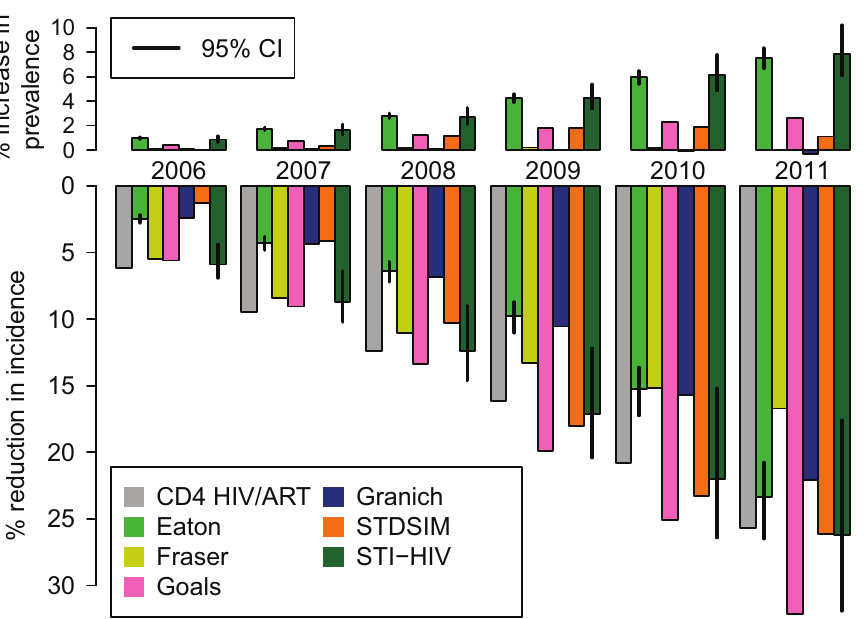
Figure 6. The impact of the existing ART programme in South Africa on HIV prevalence and incidence. The percentage increase in HIV prevalence (top) and the percentage reduction in HIV incidence rate (bottom) compared to what would have occurred in the absence of any ART for years the 2006 to 2011. These are estimated by comparing HIV prevalence and incidence in a model calibrated to the existing scale-up of ART in South Africa from 2001 to 2011 with a model simulation with no ART provision. The CD4 HIV/ART, Eaton, Goals, Granich, and STI-HIV Interaction models use the same estimates of the number starting ART each year (from [45]). Fraser uses an existing calibration to the ART scale-up in the Western Cape Province. STDSIM is calibrated to the number of people on ART in the Hlabisa subdistrict. Vertical lines on the Eaton and STI-HIV Interaction models indicate 95% credible intervals (CI).